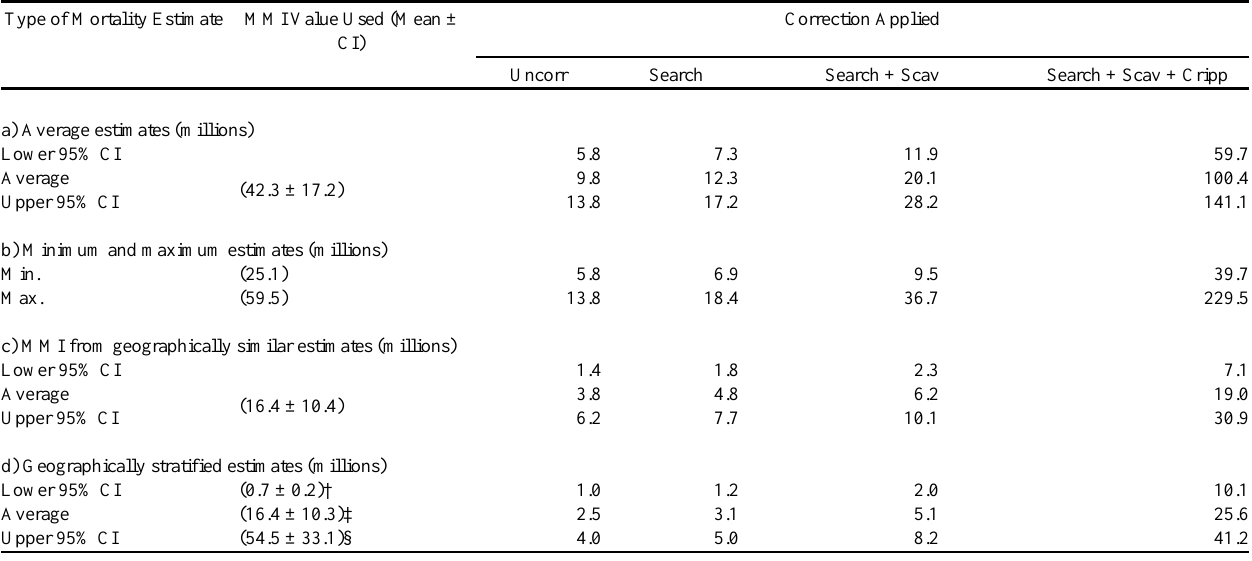
Table 2 . Estimates of annual bird mortality (in millions) from collisions with transmission lines in Canada. We applied four different estimates of the minimum mortality index (MMI = # dead birds per kilometer of transmission line per year) multiplied by the total length of transmission lines in Canada: (a) an average estimate across all suitable studies ( n = 32 study sites, “average MMI estimates”), (b) an estimate using the maximum and minimum values across all studies ( n = 32 study sites, “Minimum and maximum estimates”), (c) an estimate using MMI from geographically similar regions (data from Michigan, “MMI from geographically similar estimates,” and (d) an estimate stratified into high, average, and low rates to reflect regional variation (“geographically stratified estimates”). Stratified estimates use the average of the five lowest values in the literature (“low risk” values: 60% of transmission lines), the average of the geographically similar values to Canada (30%), and the hot spot values (10%). For each estimate, we applied a sequence of more refined correction factors: (i) MMI alone (“uncorr”), (ii) MMI plus a search correction, (iii) MMI plus search and scavenging rate (“search”), MMI plus scavenging and search rates (“scav”), (iv) MMI plus search, scavenging, and crippling rates